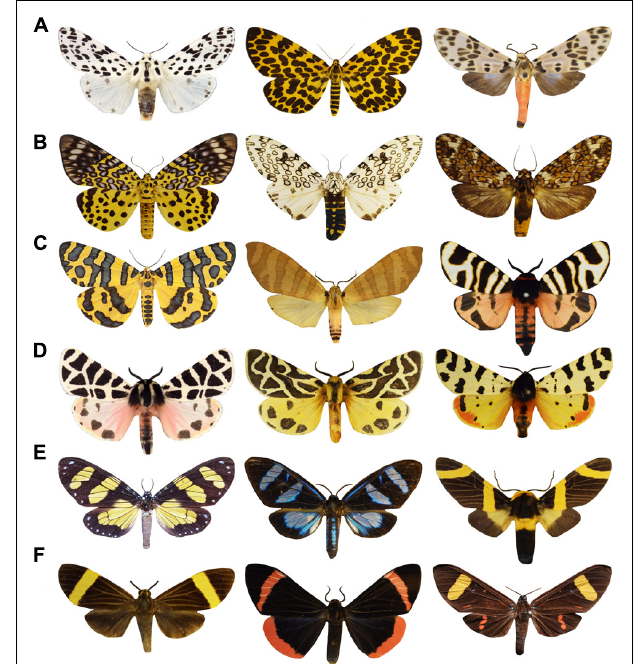
FIGURE 2 | The primary types of arctiid dorsal forewing patterning. Animals shown in row (A) exhibit single spot phenotypes (left: Hypercompe permaculata ; middle: Calpenia monilifera ; right: Delphyre roseiceps ). In these patterns, the homologous characters are composed of semi-discrete spotted elements that are one solid color. The specimens presented in row (B) exhibit concentric spot phenotypes (left: Sebastia argus ; middle: Ecpantheria scribonia ; right: Phaegoptera granifera ) in which the inner focus of the spots is a different color than the surrounding halo region. As illustrated by the animals present in row (C) , these spotted elements can fuse together to form mostly continuous bands that run from the wing’s leading anterior edge to its trailing posterior margin (left: Callimorpha bellatrix ; middle: Elysius meridionalis ; right: Eucharia festiva ). The specimens in row (D) (left: Apantesis nevadensis ; middle: Preparctia romanovi ; right: Apantesis tigrina ) exhibit more discontinuous banded patterns characterized by the presence of numerous breaks and distortions that are not as pronounced in patterns with continuous bands. Row (E) shows specimens with triple bold patterns (left: Dysschema tiresias ; middle: Agyrtidia uranophila ; right: Automolis angulosa ). Triple bold patterns are predicted to result from the fusion of banded elements along the wing’s distal-proximal axis. Patterns of this type are characterized by three mostly contiguous regions (often melanic in color) of fused primary characters separated by contrasting regions of background coloration. Finally, the species depicted in row (F) display double bold patterns brought about through additional distal-proximal fusions of banded pattern elements (left: Napata jynx ; middle: Coreura fida ; right: Histoea proserpina ). Animals showing this phenotype possess two fused regions (often melanic in color) separated by a single patch of background coloration. The phenotypic classes described in (A–F) are continuous, rather than discrete, and specimens belonging to the same species often exhibit distinct types of dorsal forewing